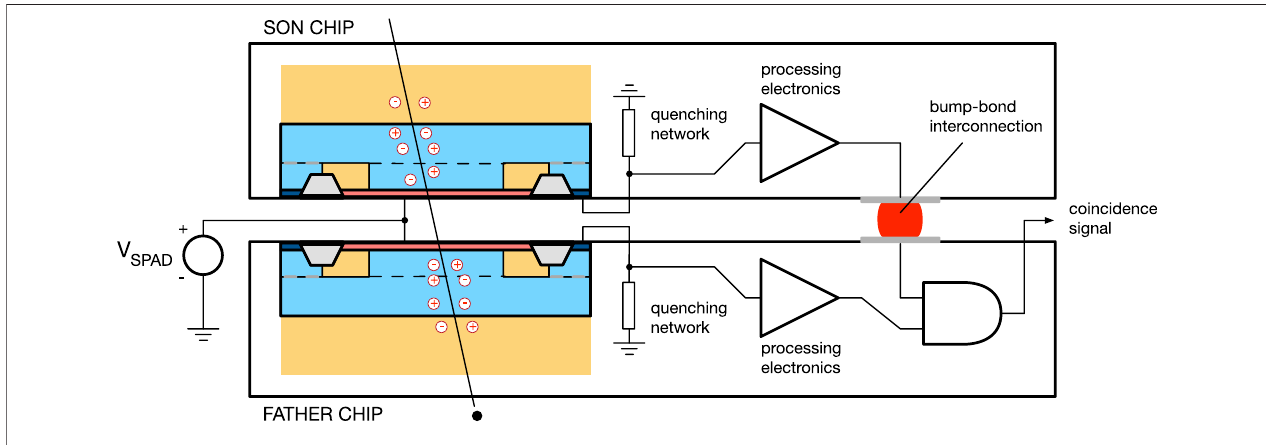
FIGURE 2 | Schematic representation of a dual-tier cell with quenching, processing and coincidence circuits. Emphasis is on the coincidence operation of the device. The six metal stack of the technology, and in particular the shielding plate against optical cross-talk between the two chips, are not